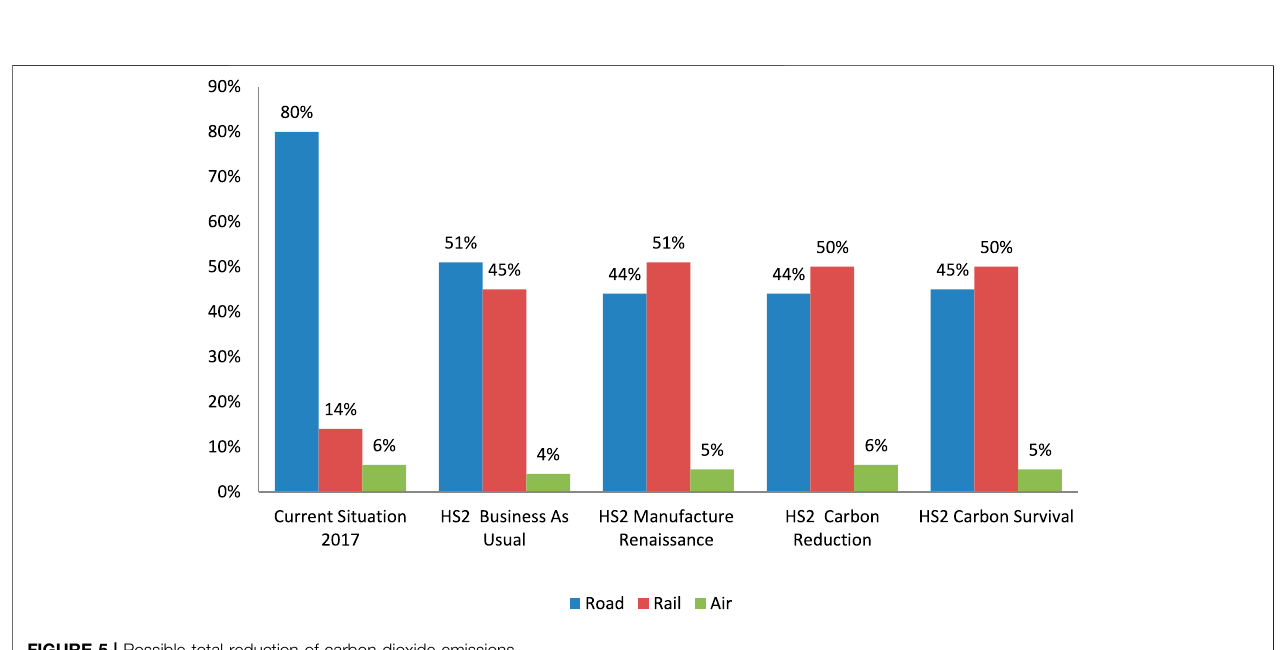
FIGURE 5 | Possible total reduction of carbon dioxide emissions.